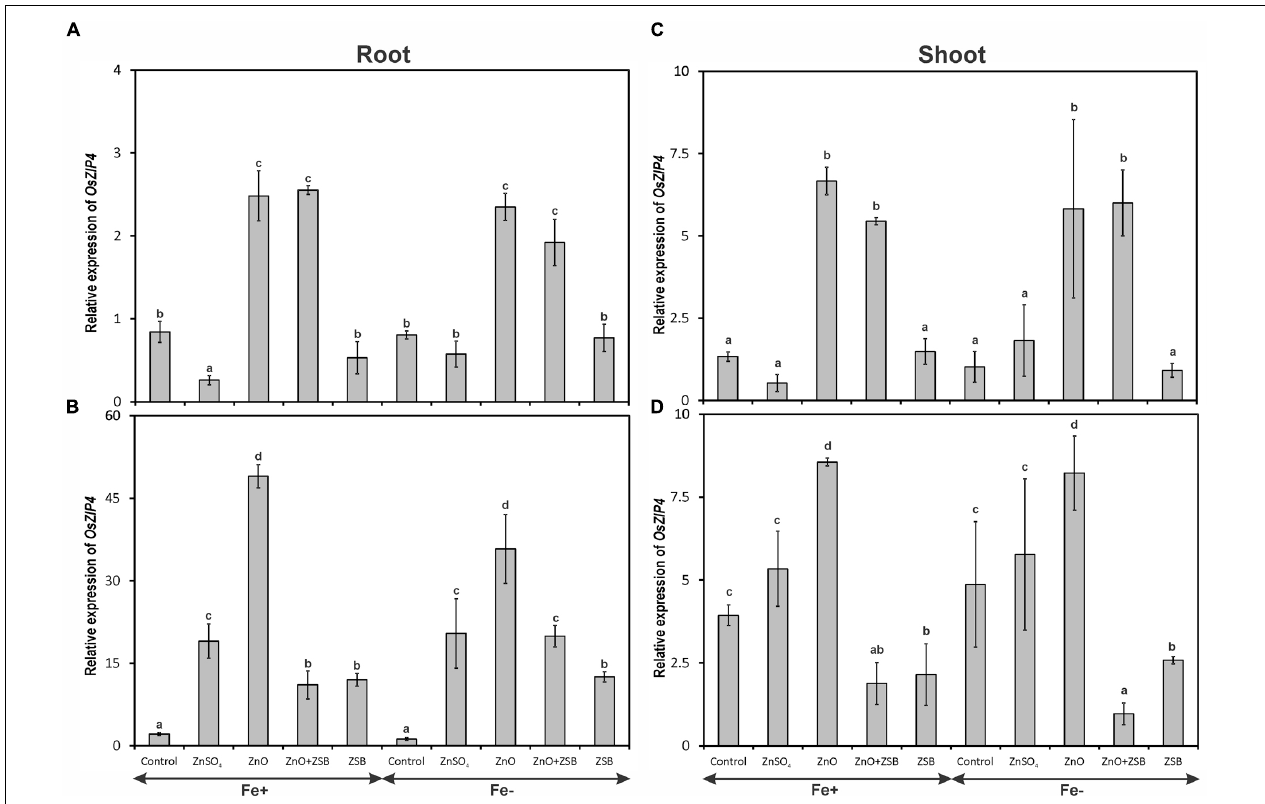
FIGURE 2 | Expression pattern of OsZIP4 in root (A,B) and shoot (C,D) of rice seedlings as influenced by Fe and Zn. (A,C) 7th day expression levels; (B,D) 14th day expression levels. Fe + , Fe sufficient condition; Fe − , Fe deficient condition. Control, No-zinc control; ZnSO 4 at 5 mM; ZnO at 10 mM; ZSB, Zinc solubilizing bacteria ( Enterobacter cloacae strain ZSB14) inoculation on 7th day. Relative mRNA abundance of OsZIP4 was quantified and normalized with OsACTIN1 gene on 7th day and 14th day. Data from real-time RT-PCR experiments were analyzed according to the 2 − (cid:49)(cid:49) Ct method. Means of six replicate values plotted, errors bars indicate the standard error. Values followed by the same letter in each panel are not significantly different from each other as determined by DMRT ( p ≤